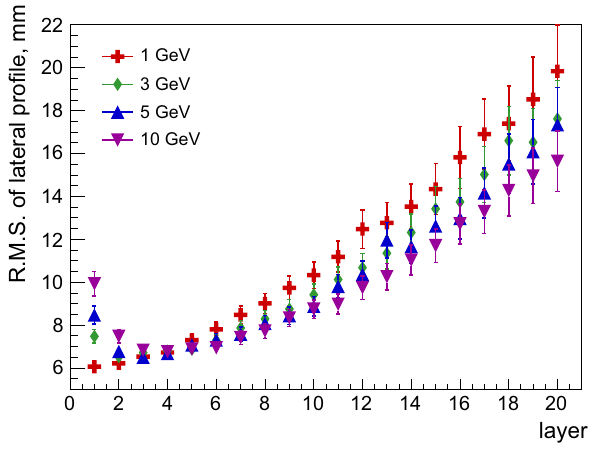
Fig. 28 Molière radius, obtained in simulation, for different electron beamenergiesasafunctionofnumberofdetectorlayersinthecalorime- ter. The insert shows an expanded view of the plane region